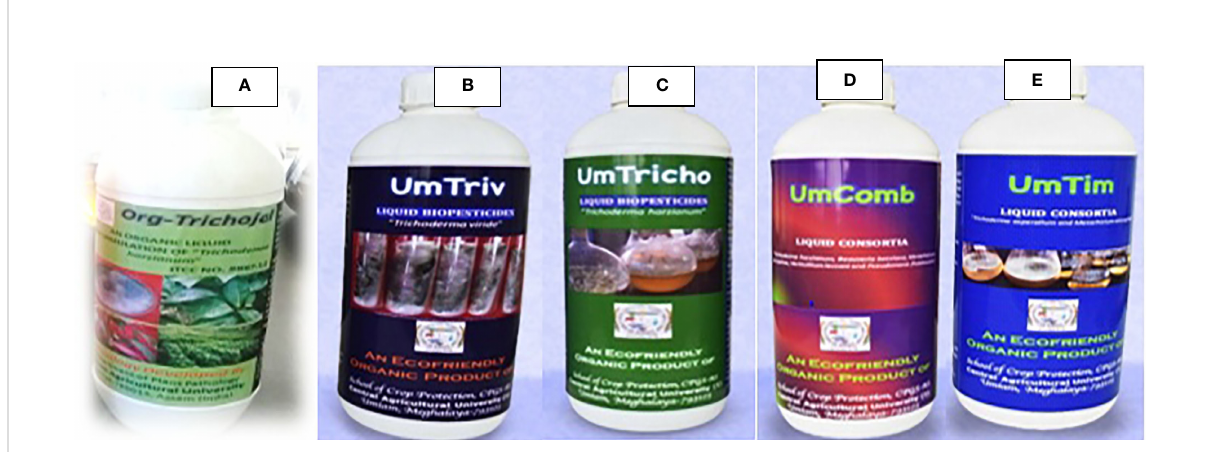
FIGURE 4 Biopesticides developed from native strains of Trichoderma spp. viz. , (A) Org-Trichojal ( T. harzianum ) in Assam and (B) UmTriv ( T. viride ), (C) UmTricho ( T. harzianum ), and Trichoderma -based consortia, (D) UmComb and I (E) UmTim in Meghalaya of NER (Source: Dutta et al.,